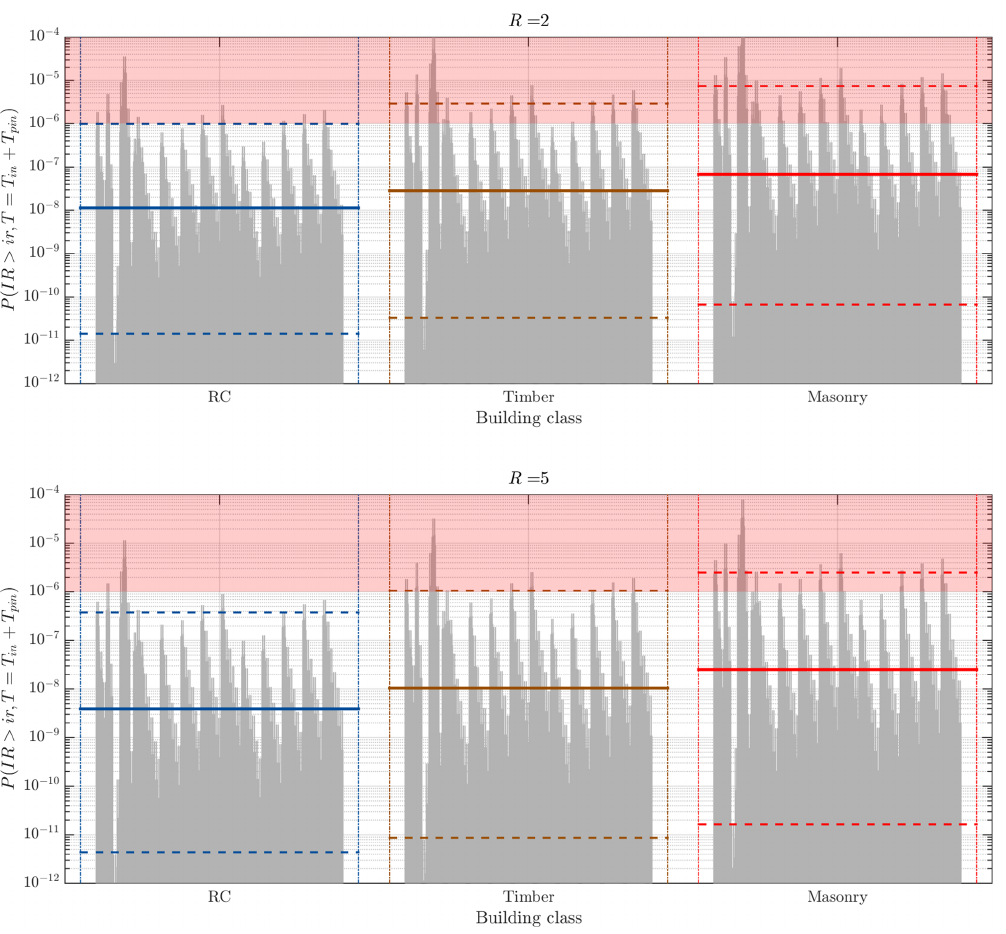
Figure 8. Marginal IR for 2 and 5km distances based on the final model (combined SM1 and SM2). The solid horizontal lines represent the weighted median values of the 1022 (13 [ a fb , b ]× 7GMPEs × 2GMICE, weight 0.5, + 60 [ a fb , b ]× 7GMPEs × 2GMICE, weight 0.5) vertical grey lines. The dashed horizontal lines represent the 10% and 90% epistemic